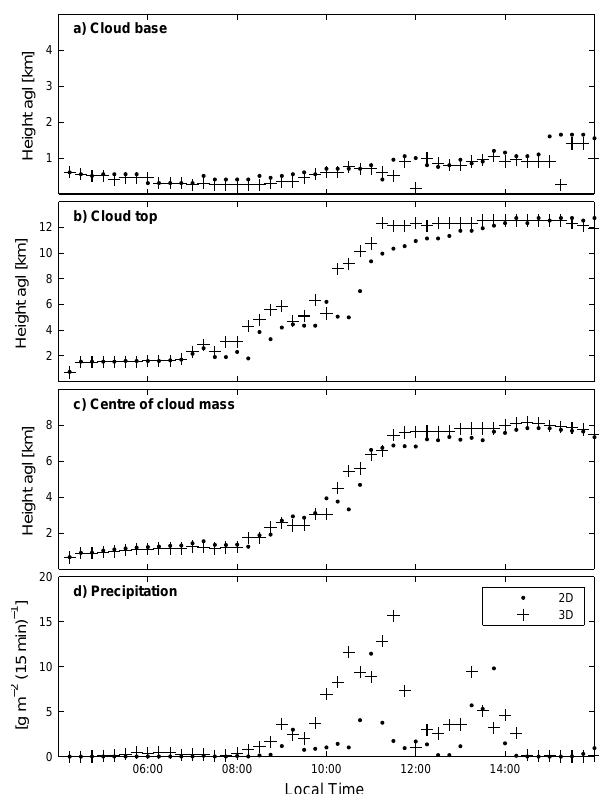
Figure 4. Comparison between the 2-D and 3-D simulation of case 2.0 × FC for (a) cloud base height, (b) cloud top height, (c) the centre of cloud mass ( Z c as defined in text) and (d) mean deposited